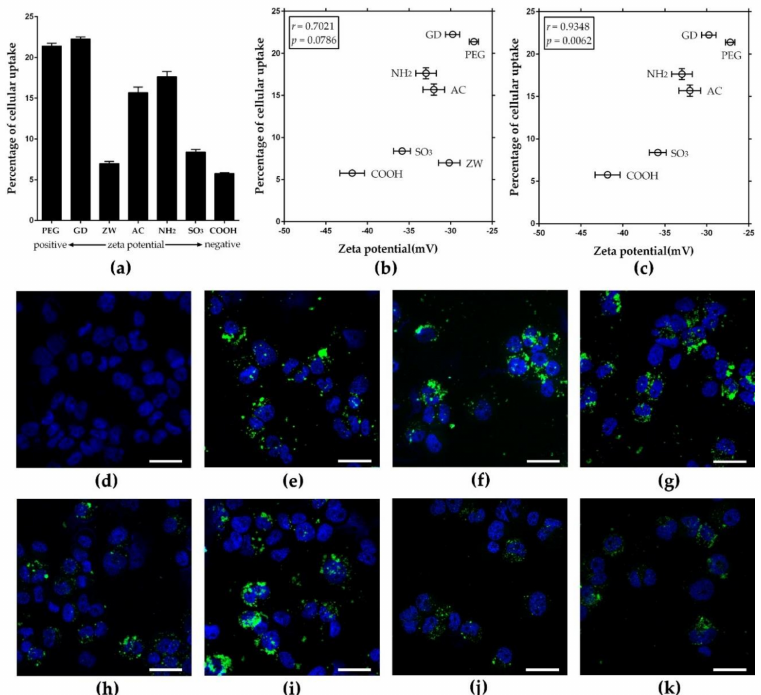
Figure 4. Cellular uptake of F -PLNPs at 50 µ g/mL by THP-1 macrophages. ( a ) The percentage of cellular uptake of F -PLNPs evaluated by fluorescence intensity. ( b ) Plotting the values of zeta potential in Roswell Park Memorial Institute medium (RPMI-1640) against percentages of cellular uptake, yielding a Pearson’s correlation coefficient of 0.7021. ( c ) Correlation plot upon excluding ZW F -PLNP of Figure 4b showed a much improved Pearson’s correlation coefficient (0.9348, p = 0.0062). Data are presented as means ± standard error of the mean (SEM); n = 4. Confocal laser scanning microscopy (CLSM) images of ( d ) vehicle control, ( e ) amine ( NH2 ) F -PLNP, ( f ) guanidium ( GD ) F -PLNP, ( g ) polyethylene glycol ( PEG ) F -PLNP, ( h ) zwitterionic ( ZW ) F -PLNP, ( i ) acetyl ( AC ) F -PLNP, ( j ) carboxyl ( COOH ) F -PLNP, and ( k ) sulfonic ( SO3 ) F -PLNP. Blue fluorescence, 4 (cid:48) ,6-diamidino-2-phenylindole (DAPI) staining; green fluorescence, F -PLNPs. Scale bar: 30 µ